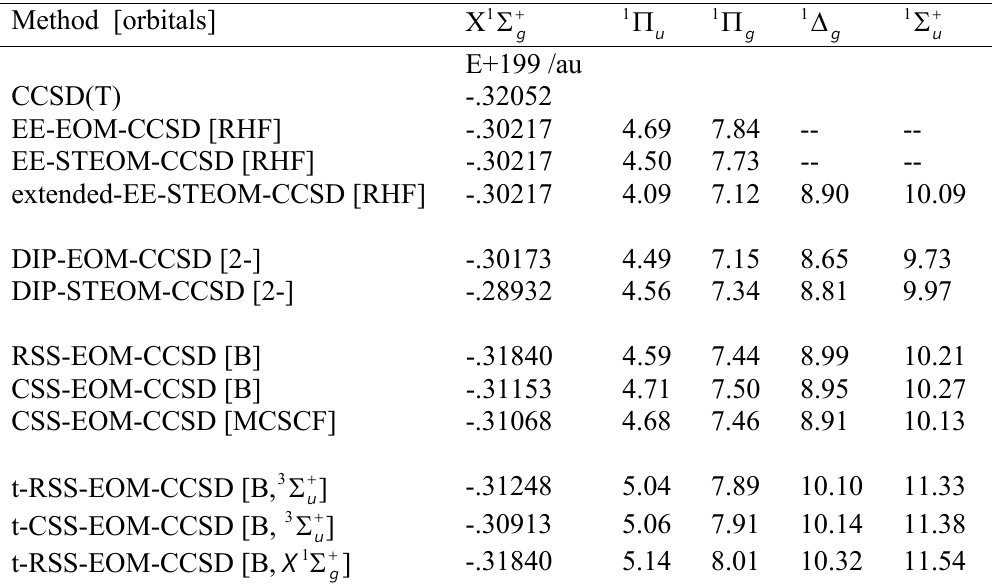
Table V. Ground state energy (in a.u.) and singlet excitation energies (in eV) for F pVTZ basis, at R=141.36